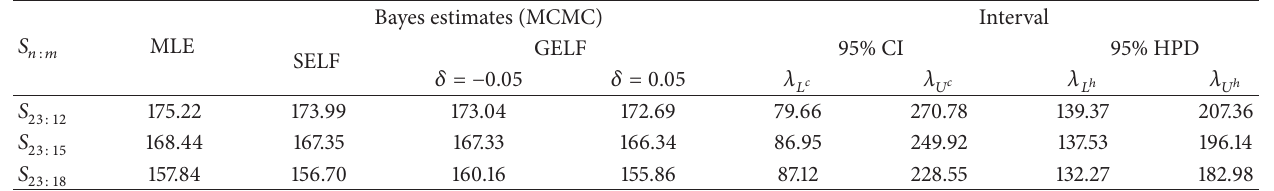
Table 9: Bayes and ML estimates, CI and HPD intervals for 𝜆 with fixed 𝑛 = 23 and 𝑝 = 0.5 under PT-II